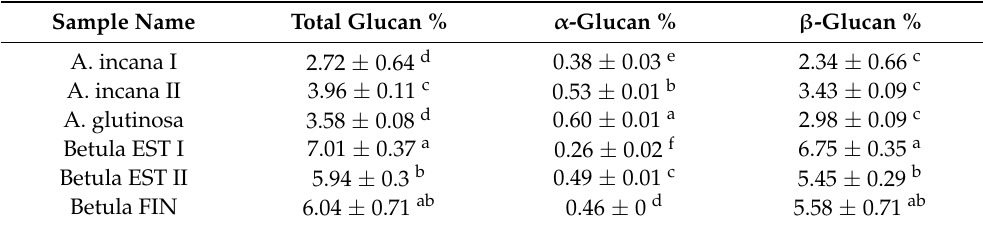
Table 3. Total content of glucan and α and β -glucan in the conk samples (in % per dry